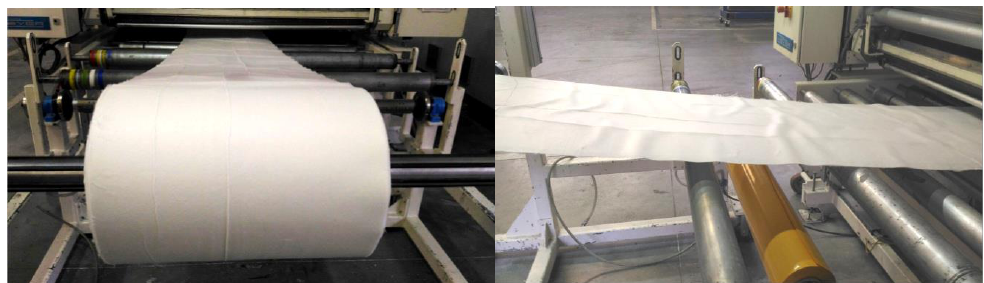
Figure 10. Visual aspects of devices for nanomaterials lamination and calibration.